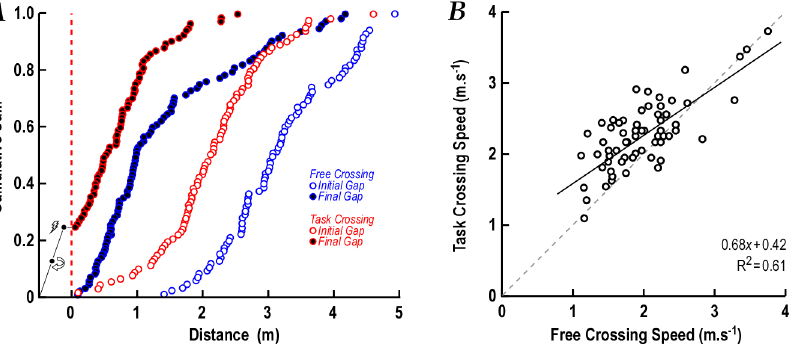
Fig 2. Initial and final gaps during the free crossing and task crossing. A. Initial and final gaps are presented as cumulative sum distributions for the group. Blue are the free-crossing data and red are the task- crossing data when given the additional ball-gathering task. During the task crossing, participants allowed smaller initial gaps leading some to be hit by the car and others missing the chance to cross ( ‘ hit ’ , 9 participants; fail,11). B. Linear regression of walking speed during the task crossing by speed during the free crossing. Those who walked slowly during the free crossing increased speed more during the task